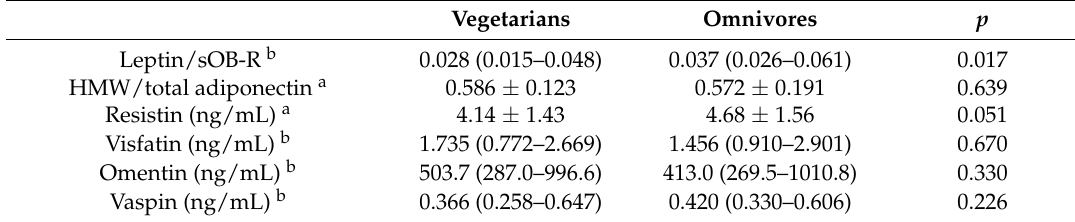
Table 2. Serum concentration of adipokines in vegetarian and omnivorous